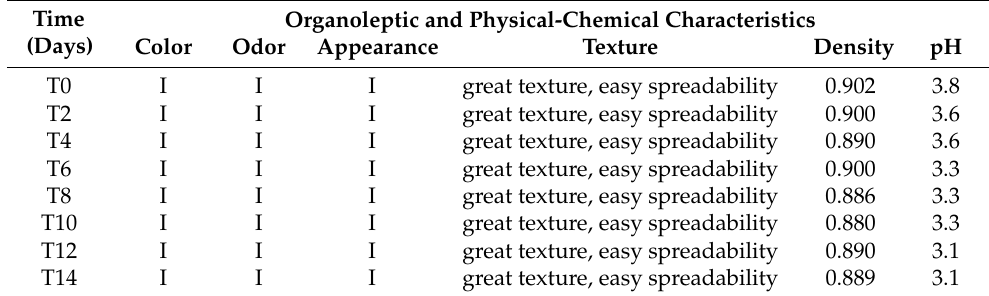
Table 3. Organoleptic and physical-chemical characteristics of gel containing L. plantarum LP-G18- A11 in preliminary stability test.